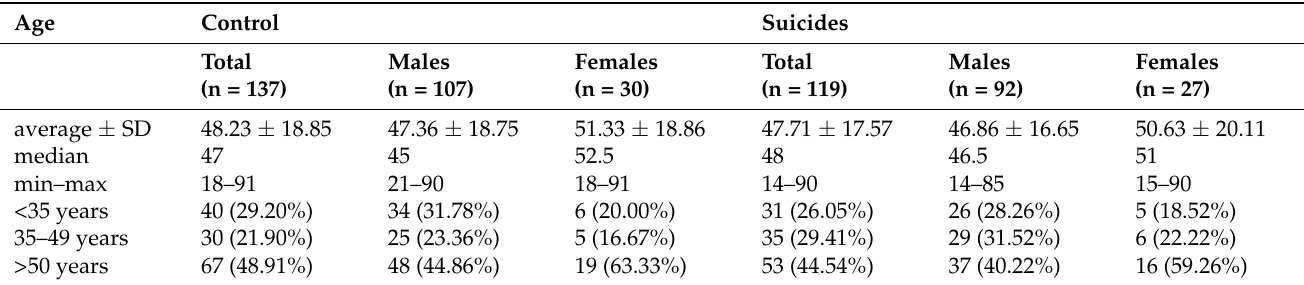
Table 2. Age characteristics of control and suicide group of the subjects.